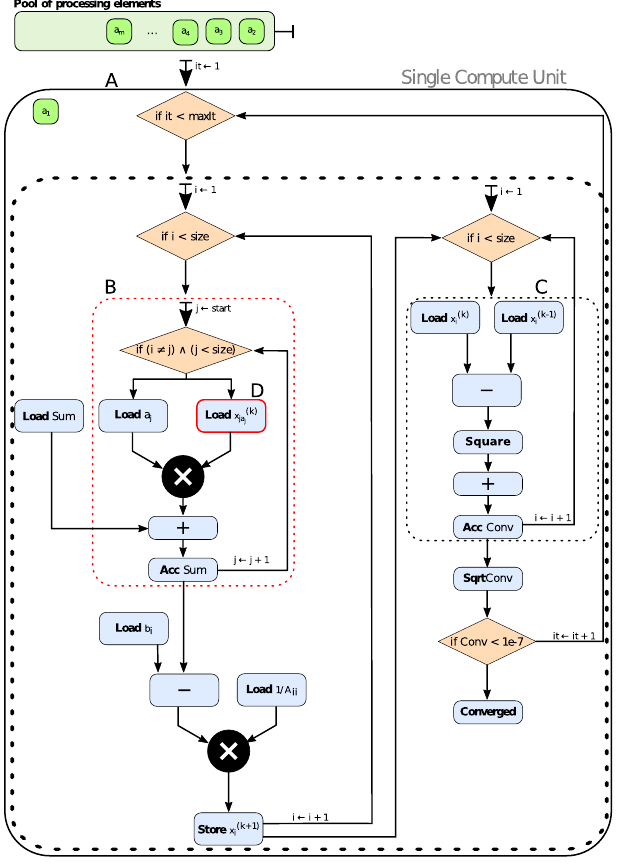
Figure 2. Block diagram of Jacobi method with single thread. Algorithm 1: QR method without reordering (herein identified as QR). Data: Initial matrix